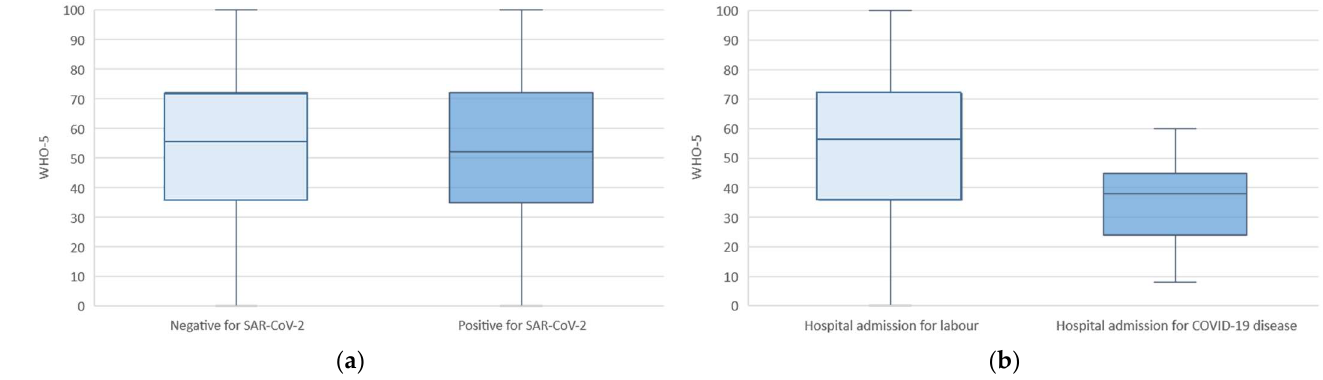
Figure 3. WHO-5 well-being outcomes for the pandemic cohort based on SARS-CoV-2 infectious status: ( a ) positive vs. negative women; ( b ) women hospitalized for moderate-severe